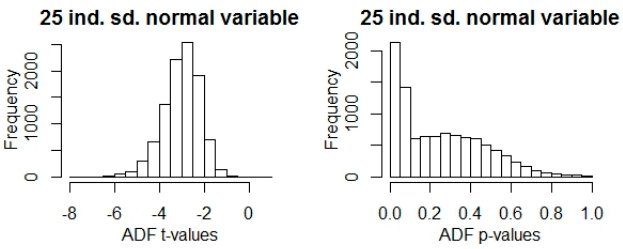
Figure 15. Histogram of ADF statistics of 10,000 independent 25 dim. standard normal sample.